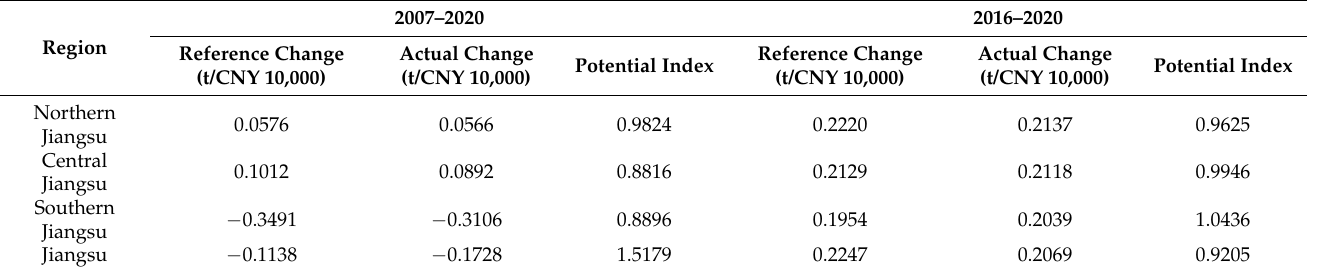
Table 9. Change of carbon emissions intensity and potential index in